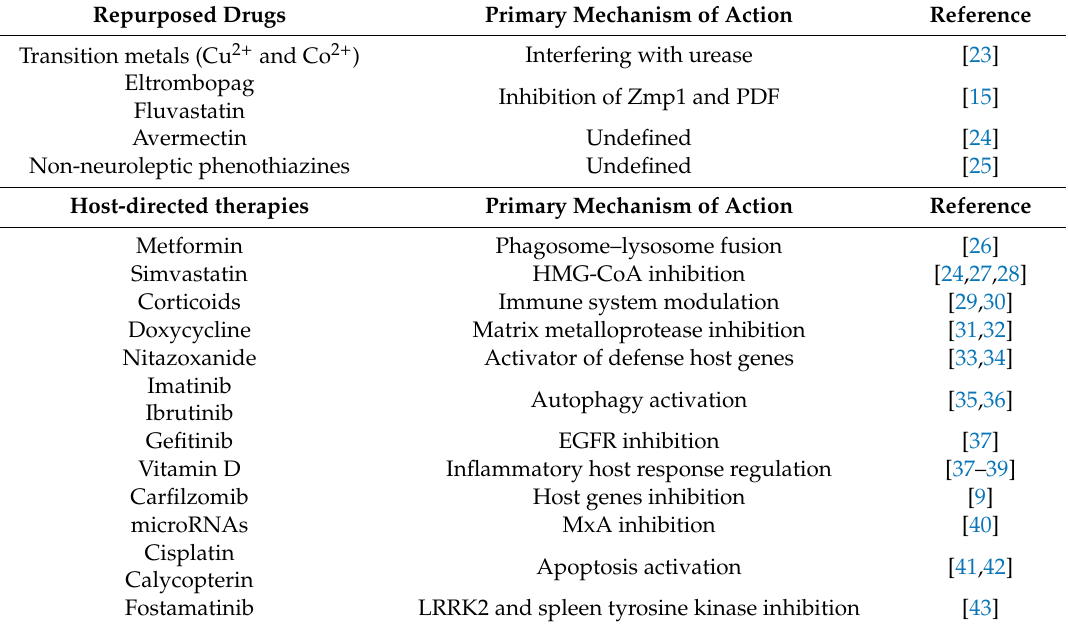
Table 1. List of antimicrobials that have been repurposed against M. tuberculosis (drug repurposing) or focused on the host (Host-directed therapies), and their primary mechanism of action. Zmp1, Zinc-dependent metalloprotease; PDF, peptide deformylase; HMG-CoA, 3-hydroxy -3-methylglutaril-coenzyme A; EGFR, epidermal growth factor receptor; MxA, myxovirus resistance protein 1; LRRK2, leucine-rich repeat kinase